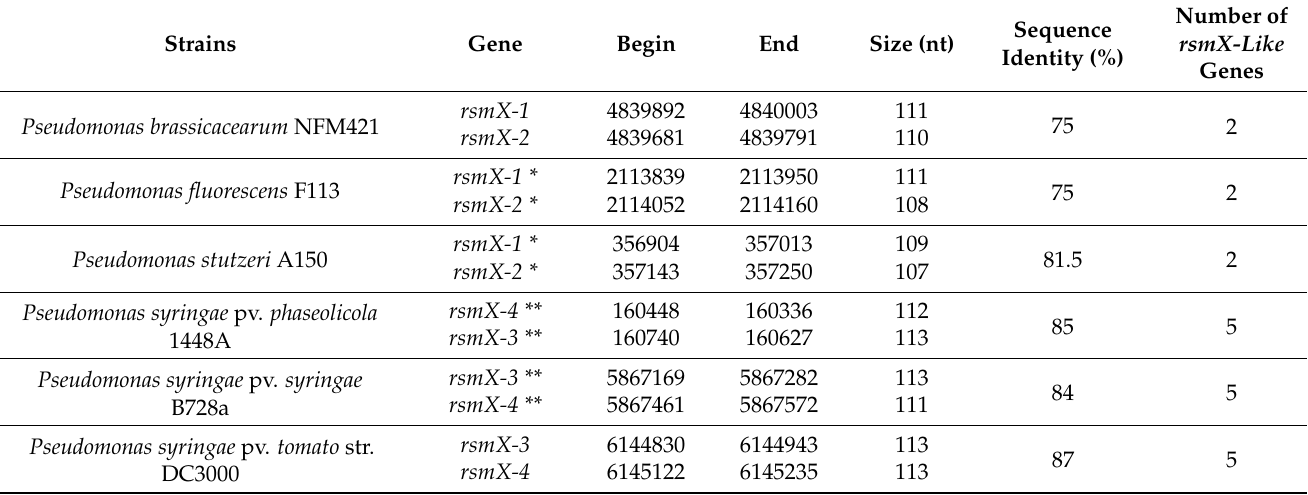
Table 1. Tandem copy of rsmX gene in Pseudomonas.